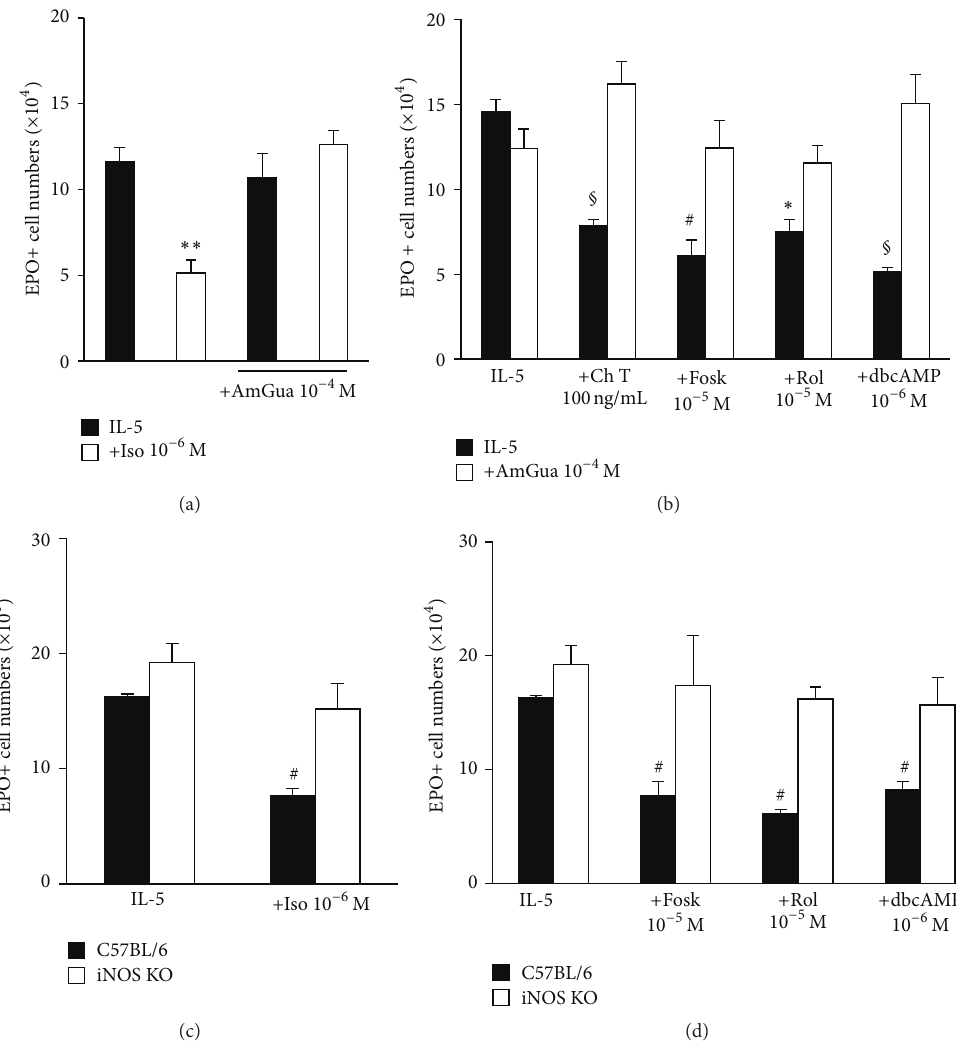
Figure 5: Isoproterenol and receptor-independent cAMP inducers/mimetics suppress eosinophilopoiesis through an iNOS-dependent mechanism. Bone-marrow cultures were established from BALB/c ((a) and (b)) or iNOS-deficient (iNOS KO) and their wild-type control (C57BL/6) mice ((c) and (d)), in the presence of IL-5, alone or associated with 10 −6 M isoproterenol (Iso) ((a) and (c)) or with the indicated concentrations of cholera toxin (Ch T) (b), forskolin (Fosk), rolipram (Rol), and dibutyryl cAMP (dbcAMP) ((b) and (d)). Where indicated, iNOS inhibitor aminoguanidine (AmGua), 10 −4 M, was used, alone or in combination with these various agonists. All agents were present from the beginning of culture for a 7-day period. Data (mean + SEM; 𝑛 = 4 in (a), 𝑛 = 3 remaining panels) are the numbers of EPO+ cells recovered at the end of the culture. Significant differences relative to the respective IL-5 controls: ∗ 𝑃 ≤ 0.05 , ∗∗ 𝑃 ≤ 0.01 , § 𝑃 ≤ 0.005 , # 𝑃 ≤ 0.0025